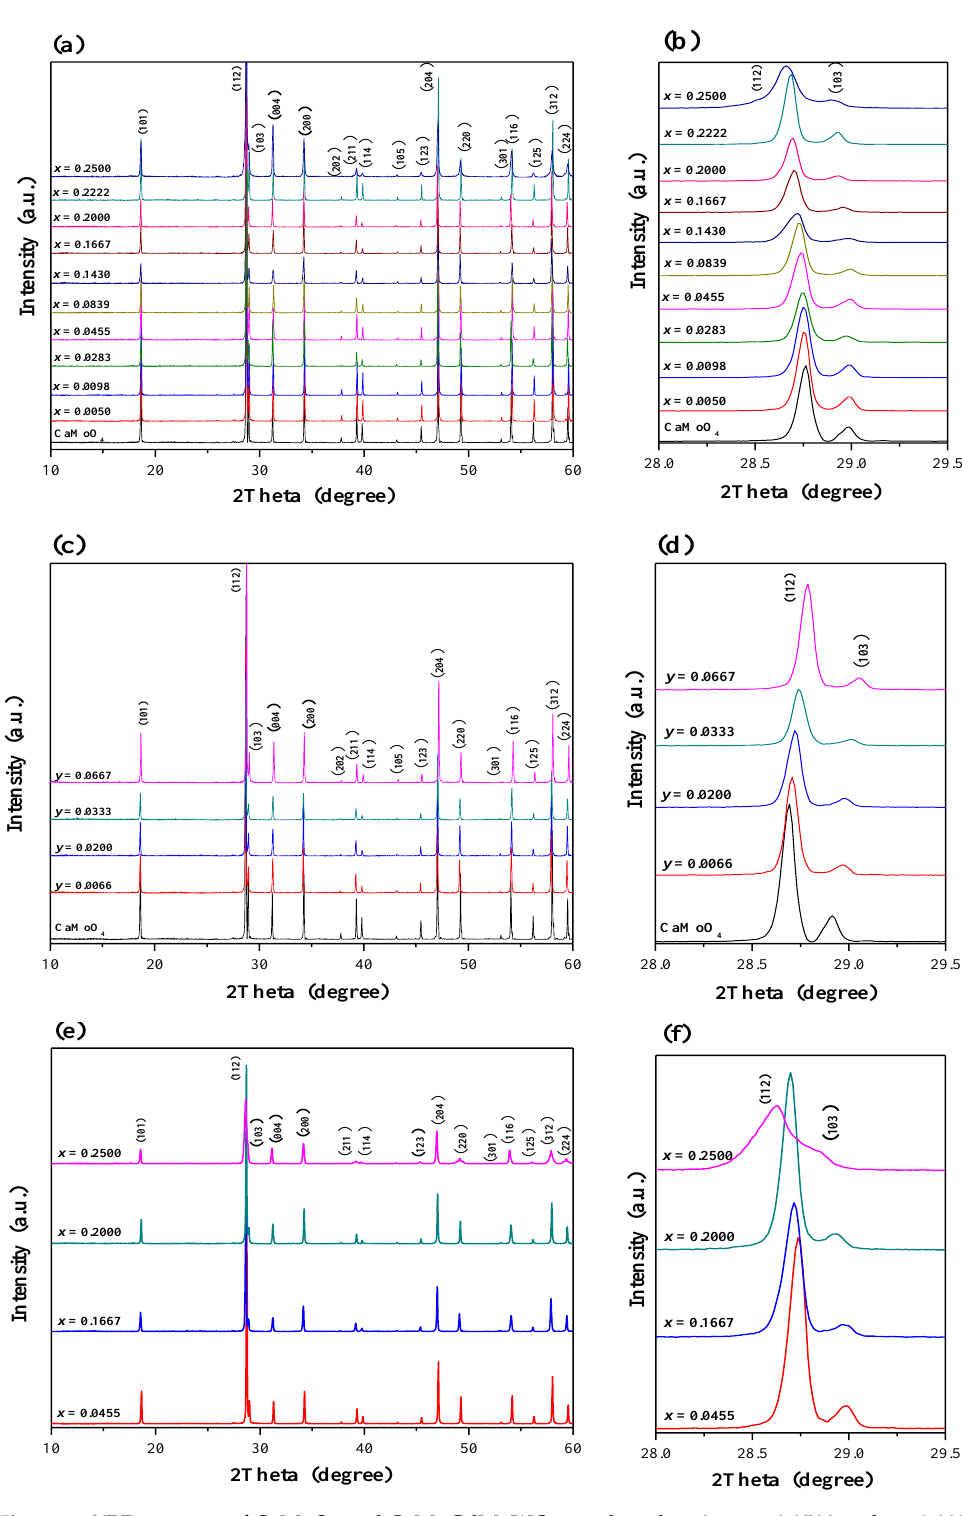
Figure 2. XRD patterns of CaMoO 4 and CaMnGdMoWO samples when 0 < x ≤ 0.2500 and y = 0.0020 ( a , b ) — solid-state reaction method; ( e , f ) — combustion route; when 0 < y ≤ 0.0667 and x = 0.1667 ( c , d ) — solid- state reaction method.